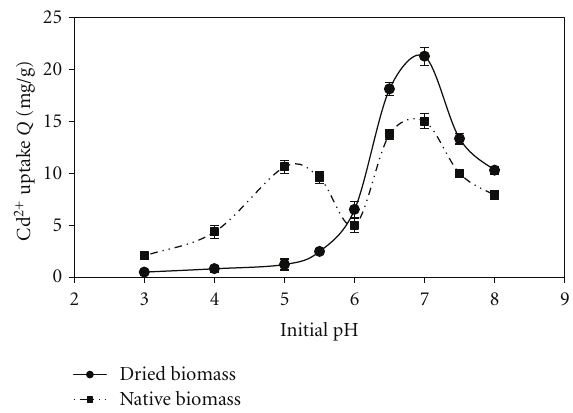
Figure 1: pH profile of Cd(II) uptakes by native and dried biomass at initial concentration of 10 ppm; temperature 25 ◦ C.